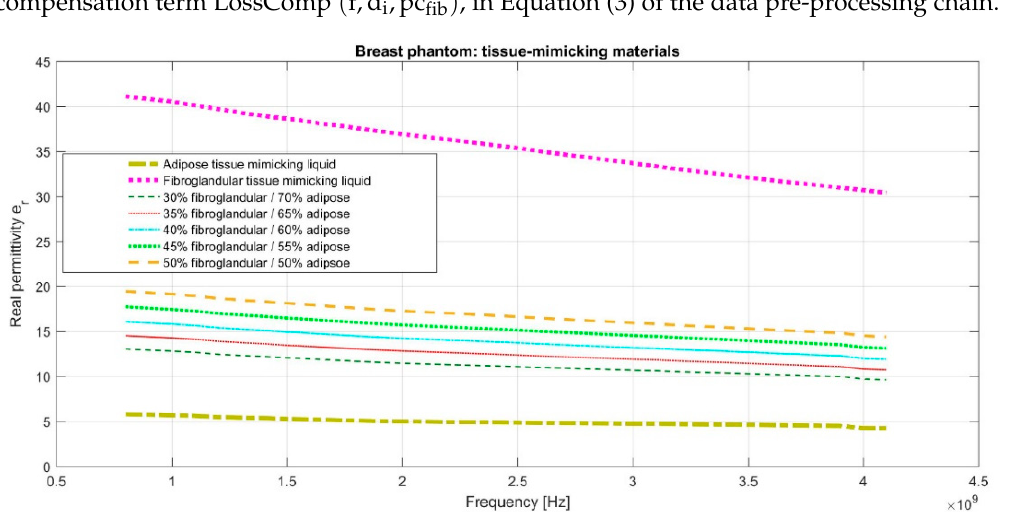
Figure 8. “Average” equivalent dielectric constant along a bistatic path through the breast, under various assumptions on the percentage of fibroglandular tissue pc fib . Applicability to the breast phantoms used for the design validation of the microwave breast imaging system.